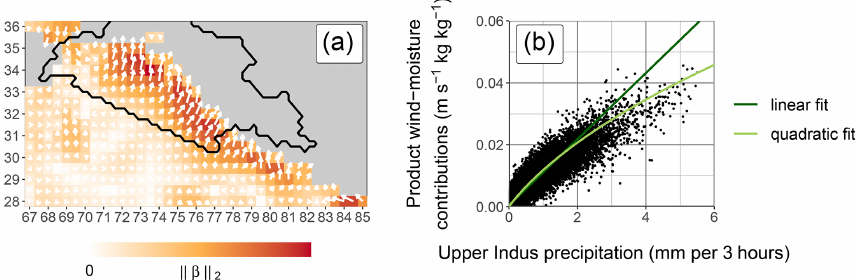
Figure 2. Results of the wintertime regression of precipitation with meridional and zonal moisture transport at 700hPa. Precipitation is defined as the 3-hourly average over the UIB (black contour, panel a ). Panel (a) shows the coefficients associated with each predictor. The arrows indicate the most efficient direction of moisture transport while the length and the colour of the arrows indicate the total weight of moisture transport (i.e. the Euclidean norm of the coefficients from both zonal and meridional components). The exact values of the coefficients are not interpretable and are therefore not indicated. Panel (b) is the scatter plot of the product of wind and moisture contributions against precipitation, with the green lines representing two types of